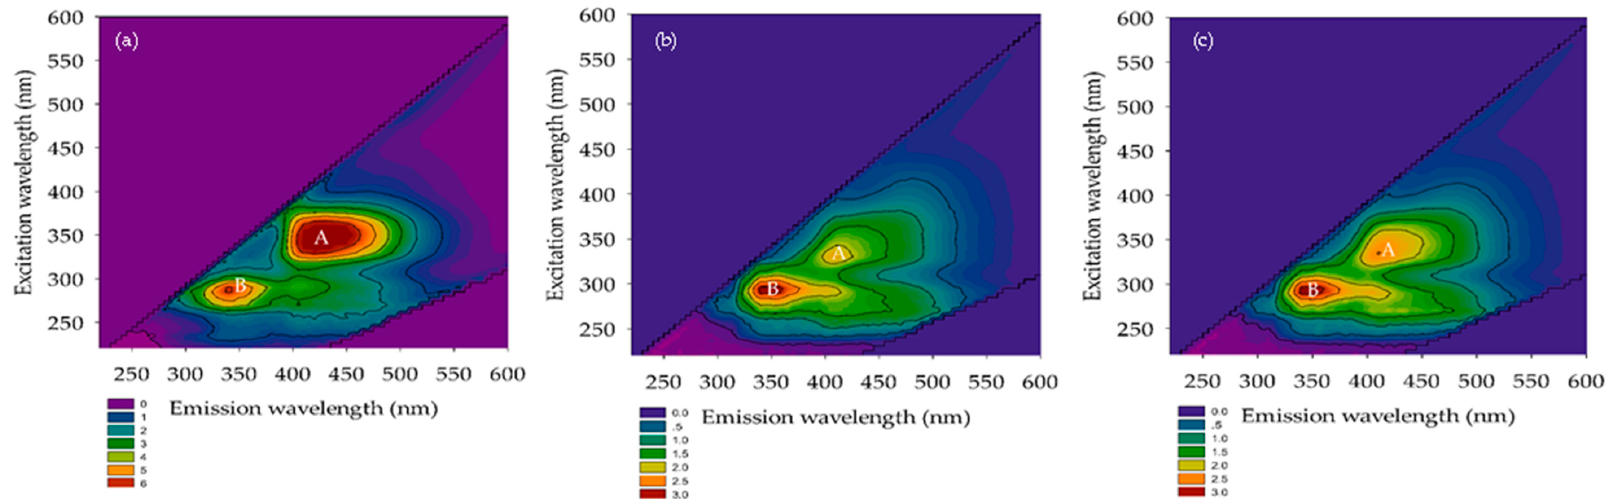
Figure 8. FEEM of the A/O-MBR and O-MBR systems at a SRT of 10 days. ( a ) Raw wastewater. ( b ) Permeate from A/O-MBR (System 1). ( c ) Permeate from O-MBR (System 2).